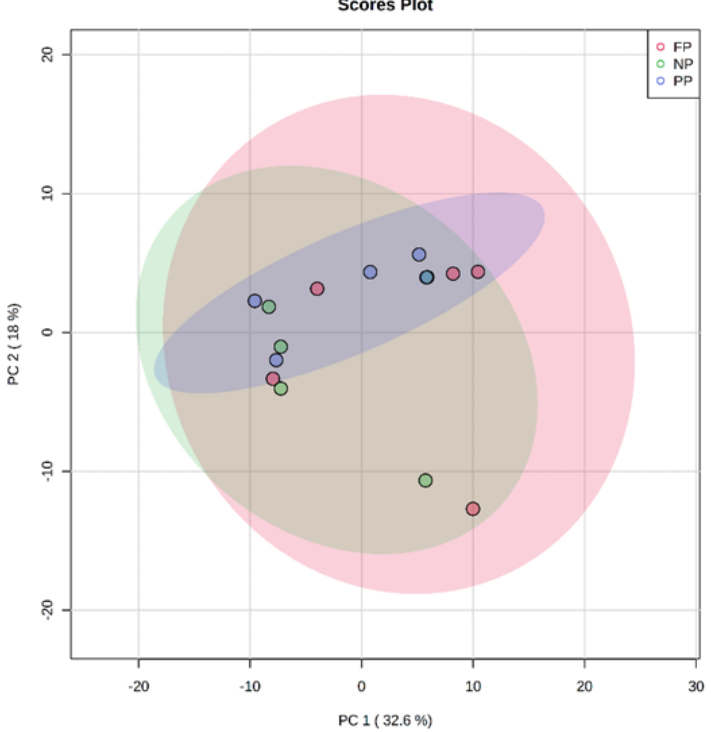
Figure 1. Principal component analysis (PCA) scores plot of metabolome distribution of bulls’ blood plasma in the rearing phase among the treatments (NP, PP, and FP).